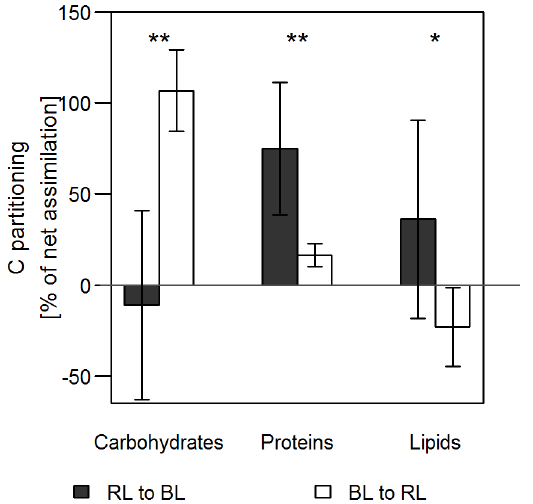
Figure 5. Carbon partitioning. The relative partitioning of C (carbon) into carbohydrates, proteins and lipids was calculated for the 2 h following the light quality changes. Data were calculated on the basis of the FTIR spectra and the net rate of carbon assimilation and, therefore, add up to 100% net carbon assimilation (carbohydrate + protein + lipid bar). Values below zero mean a net loss. Shown are the first 2 h after the light quality change from RL to BL and vice versa. n=3–6. The exact values are specified in Table